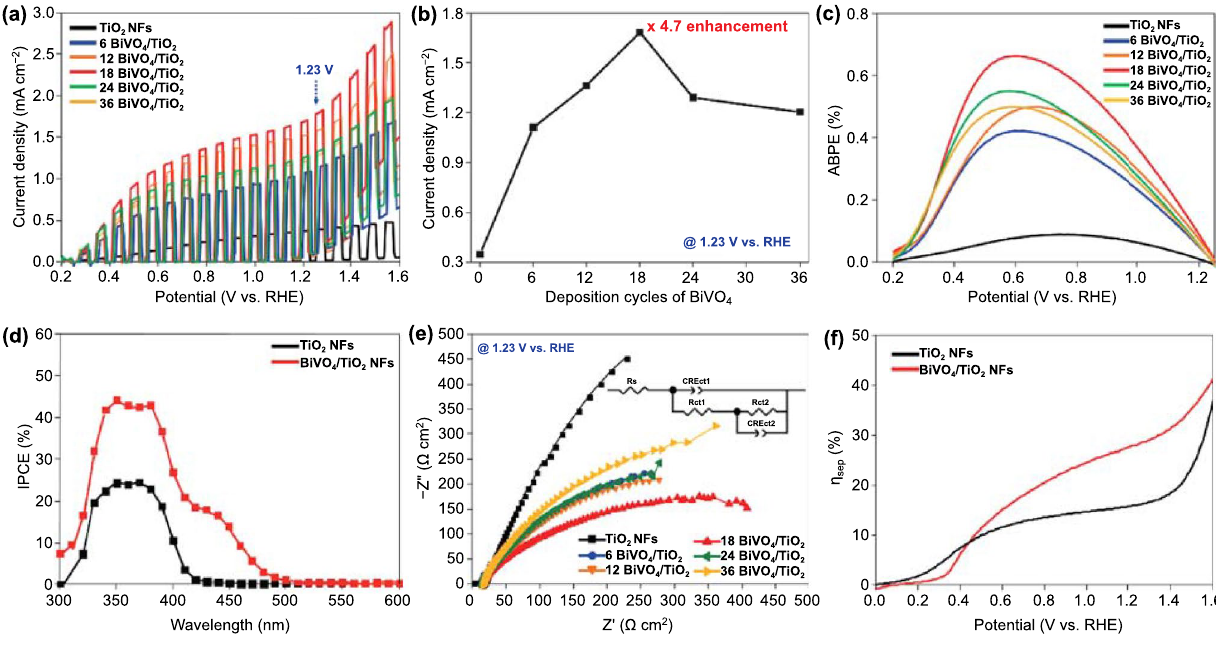
Fig. 4 a LSV of TiO 2 NFs and BiVO 4 /TiO 2 NFs with different deposition cycles of BiVO 4 in 0.5M K–P i buffer with 1M Na 2 SO 3 . b Photocur‑ rent density of BiVO 4 /TiO 2 NFs with different deposition cycles of BiVO 4 at 1.23 V (vs. RHE). c ABPE of TiO 2 NFs and BiVO 4 /TiO 2 NFs with different deposition cycles of BiVO 4 . d IPCE at 1.23 V (vs. RHE) of TiO 2 NFs and 18 BiVO 4 /TiO 2 NFs. e EIS of TiO 2 NFs and BiVO 4 / TiO 2 NFs with different deposition cycles of BiVO 4 at 1.23 V (vs. RHE) in 0.5M K–P i buffer with 1M Na 2 SO 3 . Inset shows equivalent circuit. f Charge separation efficiency of TiO 2 NFs and 18 BiVO 4 /TiO 2